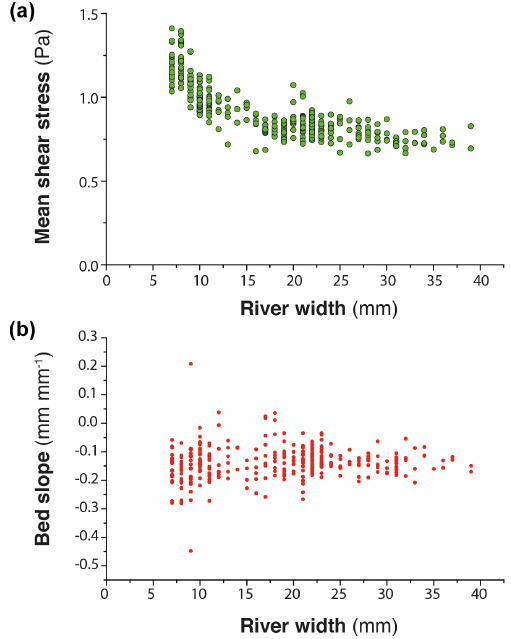
Figure 14. (a) Riverbed shear stress versus river width in the down- stream section, 40cm long, of experiment BL15 at runtime 925 (see also Fig. 12). (b) Corresponding slope of the